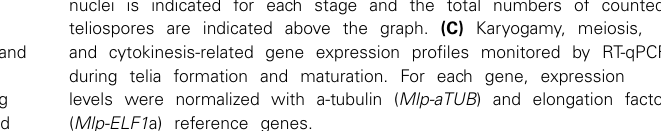
nuclei is indicated for each stage and the total numbers of counted teliospores are indicated above the graph. (C) Karyogamy, meiosis, and cytokinesis-related gene expression profiles monitored by RT-qPCR during telia formation and maturation. For each gene, expression levels were normalized with a-tubulin ( Mlp-aTUB ) and elongation factor ( Mlp-ELF1 a) reference